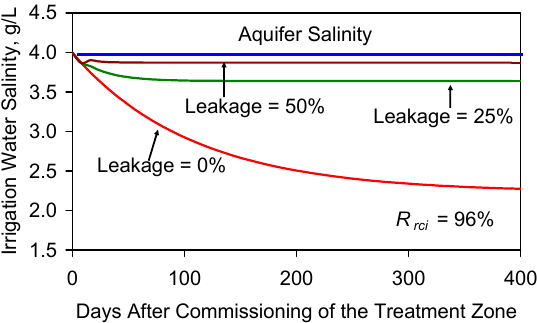
Figure F2. Change in salinity of the irrigation water abstracted from the modeled Aquifer Treatment Zone with time. Aquifer salinity = 4 g/L. Process Flow Diagram = Figure 20. R rci = Reinjection ratio = 480/500. z 8 (leakage) = ( n /( y + n )). Assumptions: (i) n = 0 m 3 ·day − 1 . Leakage = 0%; (ii) n = 120 m 3 ·day − 1 ; Leakage = 25%; (iii) n = 240 m 3 ·day − 1 . Leakage = 50%; Aquifer Thickness = 1 m; Rate Constant = Figure B2b.